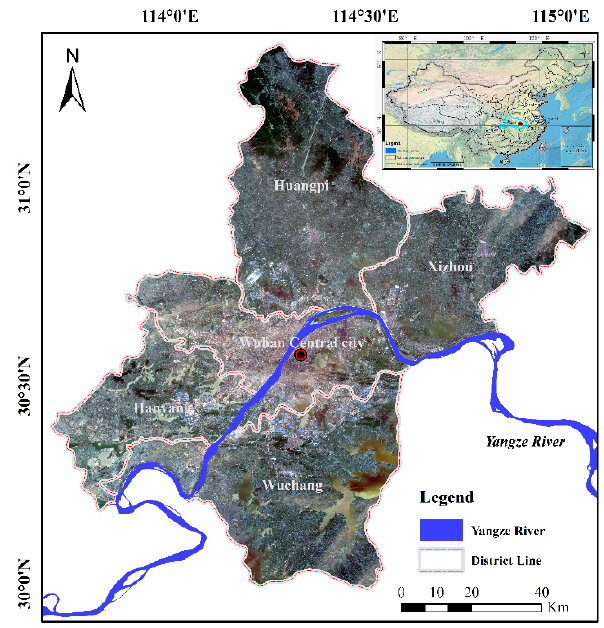
Figure 2. Location of the study areas.